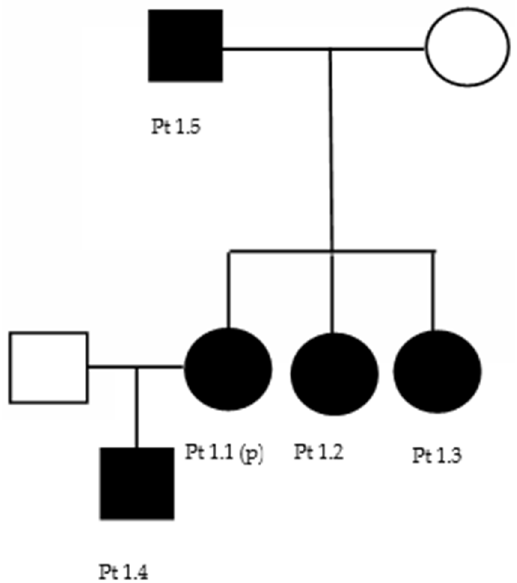
Figure A1. Family 1 pedigree.